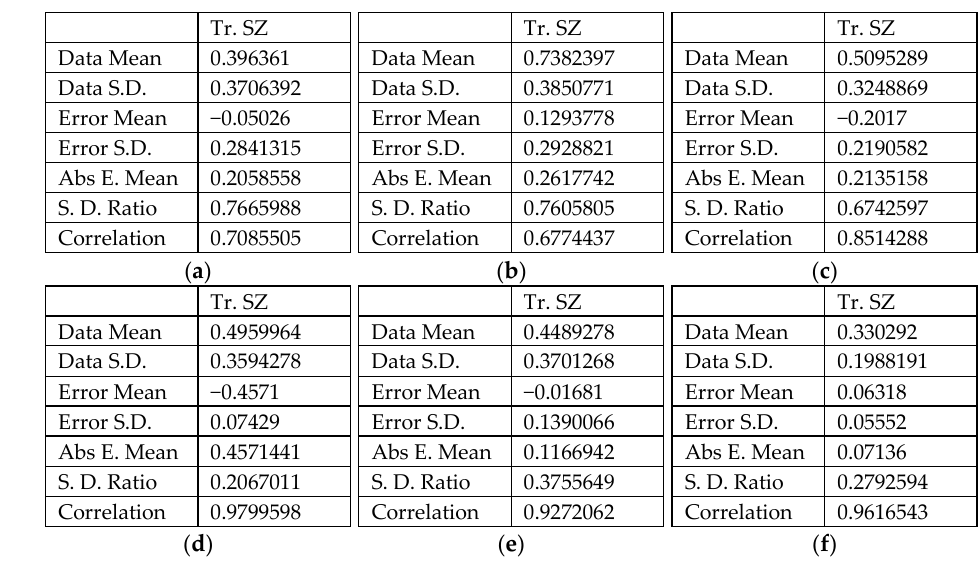
Figure 7. Basic regression parameters of the artificial neural networks modelling the effect of process parameters on roughness parameters Sa ( a – c ) and Sz ( d – f ): ( a , d ) 0.4-mm-thick EN AW-2024-T3 Alclad, ( b , e ) 1-mm-thick EN AW-2024-T3 and ( c , f ) 0.8-mm-thick EN AW-7075-T6 Alclad: Data S.D.—standard deviation of data, Error S.D.—error of standard deviation, Abs. E. Mean—absolute error mean, S.D. Ratio—standard deviation ratio, Correlation—coefficient of determination R 2 .